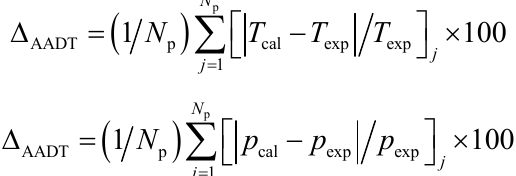
hydrate in different 2